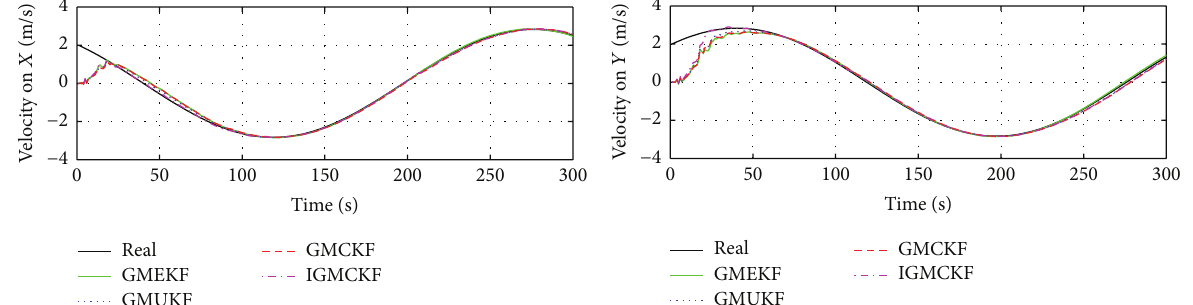
Figure 5: The tracking curve of velocity components.